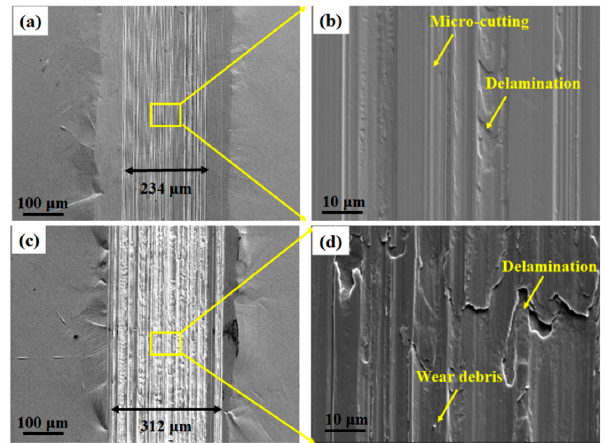
Figure 5. Scanning electron microscopy (SEM) images of the worn surfaces of the 304 stainless steel samples with a grain size of ( a ) 48 μ m and ( c ) 92 μ m after dry sliding test with an applied load of 80 N. ( b , d ) correspond to the enlarged view in the yellow box in ( a ) and ( c ) showing the wear mechanism.